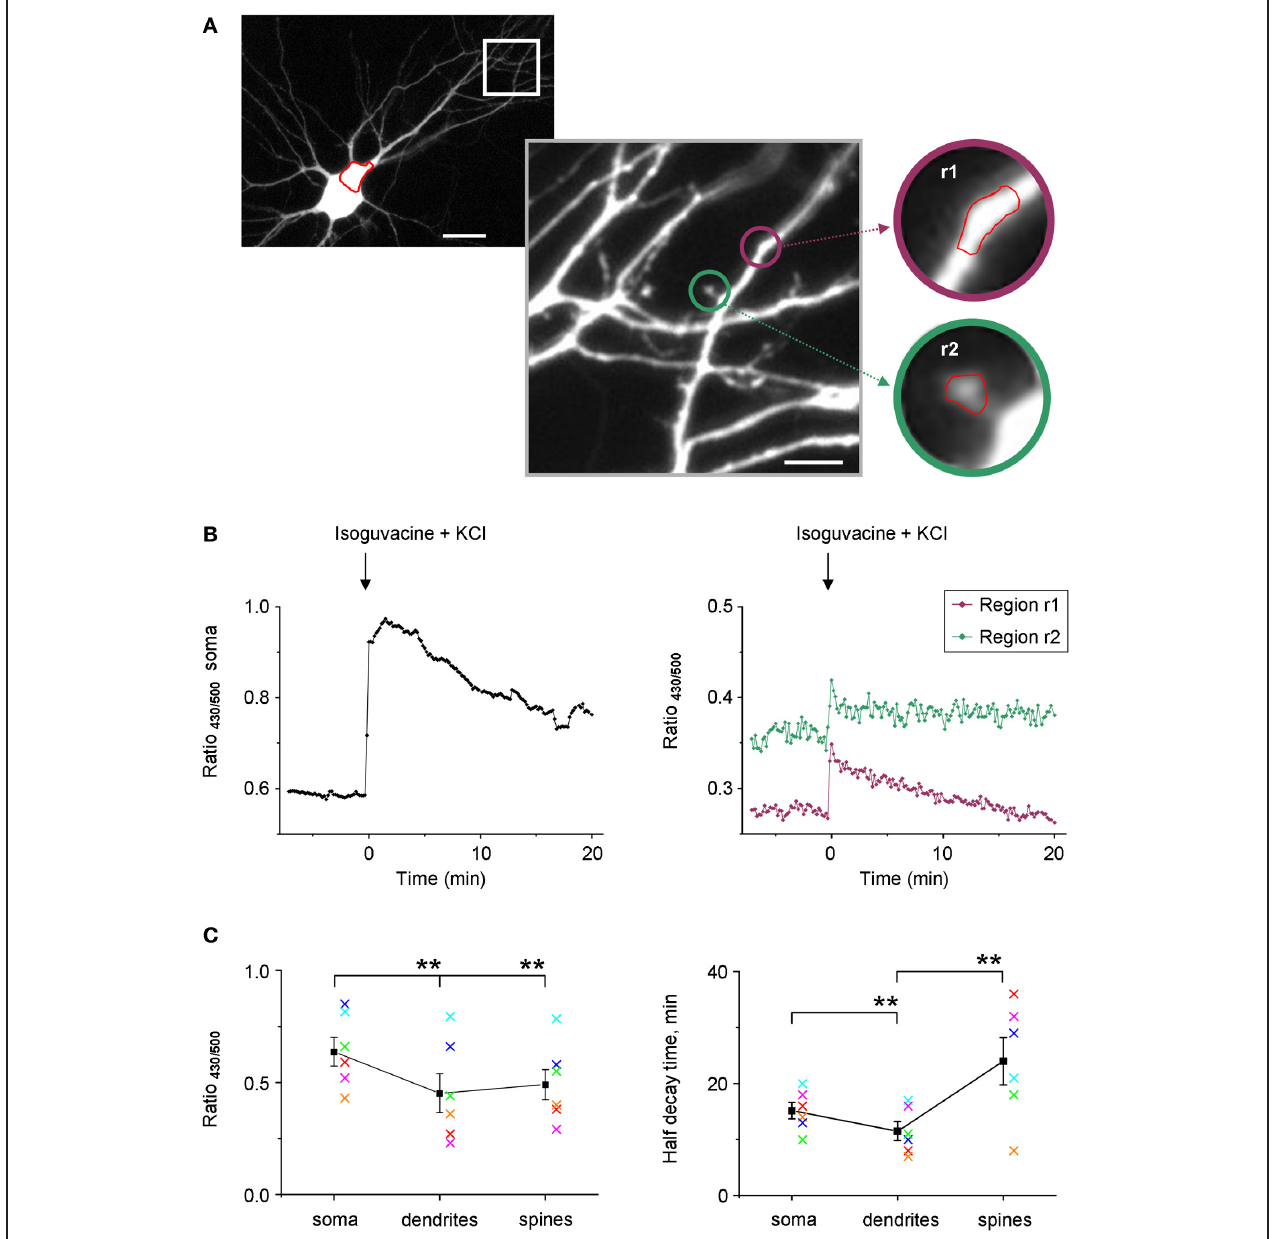
FIGURE 9 | Stable recording of Cl-Sensor fluorescence from neuronal dendrites and spines. (A) Cultured hippocampal neuron expressing Cl-Sensor (13 days in vitro , E19 embryos). The selected dendrite region is shown in greater digital magnification. This image represents one of original sequential images taken during fluorescence measurements (500nm excitation filter). Scale 20 μ m in left panel and 5 μ m in right panel. The insets illustrate regions of interest (r1 and r2) drawn on a dendrite and on a spine for analysis of fluorescence dynamics.